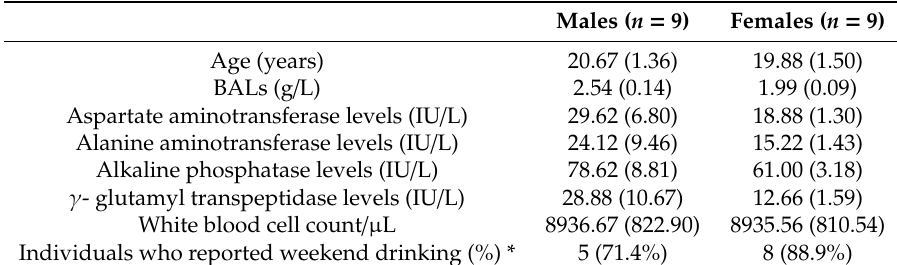
Table 1. Characteristics of individuals with acute alcohol